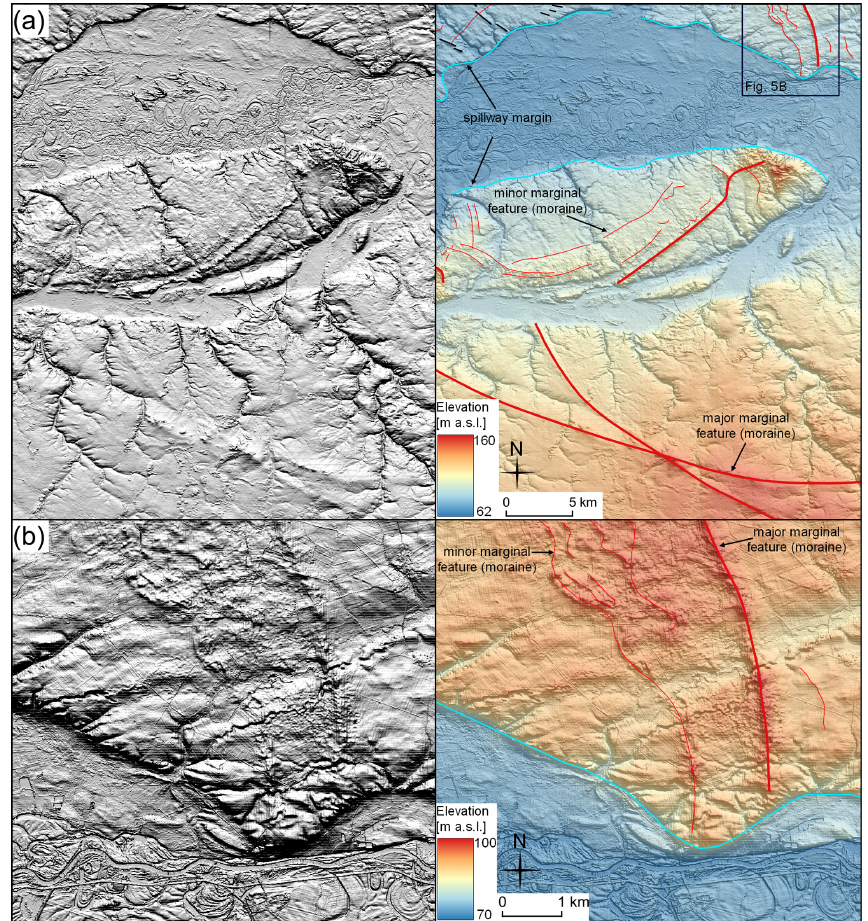
Figure 6. Examples of marginal features as a hillshade model (left) and DEM superimposed on hillshade model (right). (a) Cross-cutting of major marginal moraines. (b) Close-up on minor marginal moraines. Notice the prominent ice-marginal spillway disturbing the continuity of other glacial